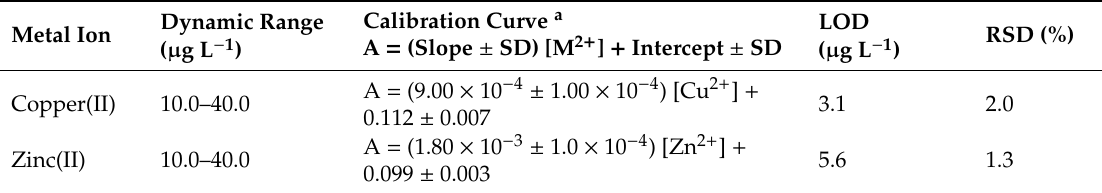
Table 2. Calibration curves and dynamic concentration ranges for copper(II) and zinc(II) and their respective limits of detection (LOD). A, absorbance; SD, standard deviation; M 2 + , metal